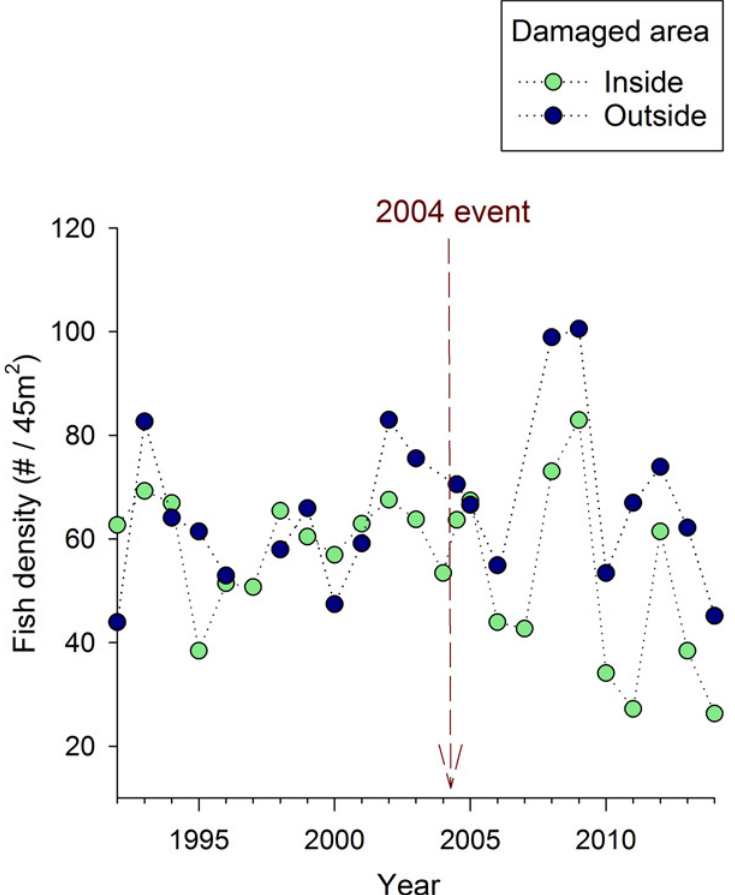
Fig 5. Mean adult fish density over time at Crab Cove, showing changes inside and outside the area damaged by the 2004 anchoring event. The dotted vertical line indicates the timing of the 2004 anchoring